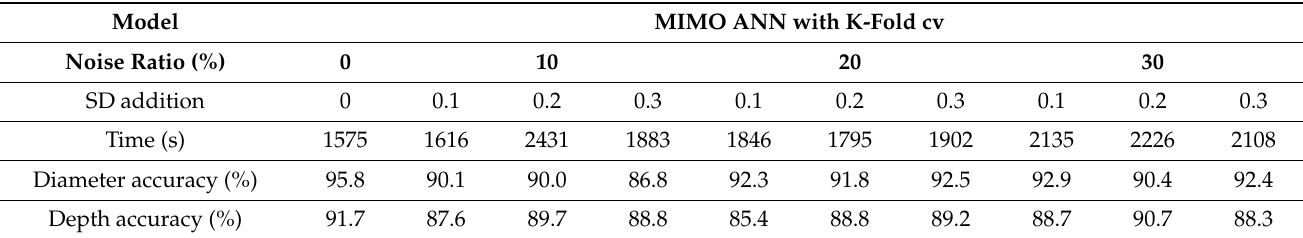
Table 17. Statistical tests of MIMO ANN with K-fold cross-validation